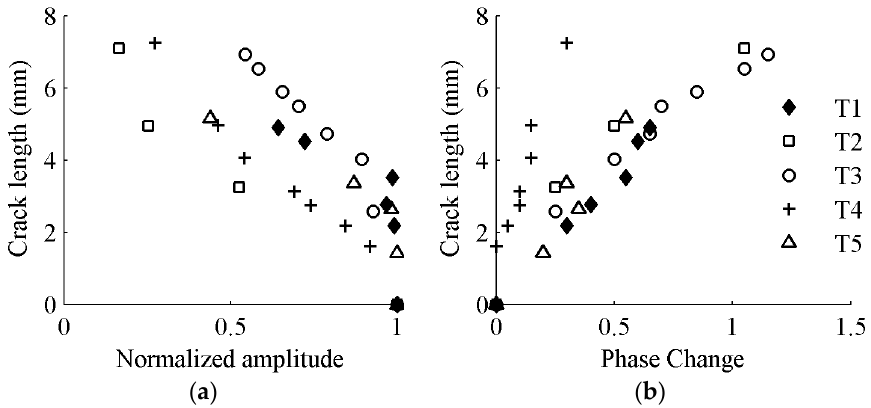
Figure 15. Experimental setup for riveted lap-joint fatigue tests.